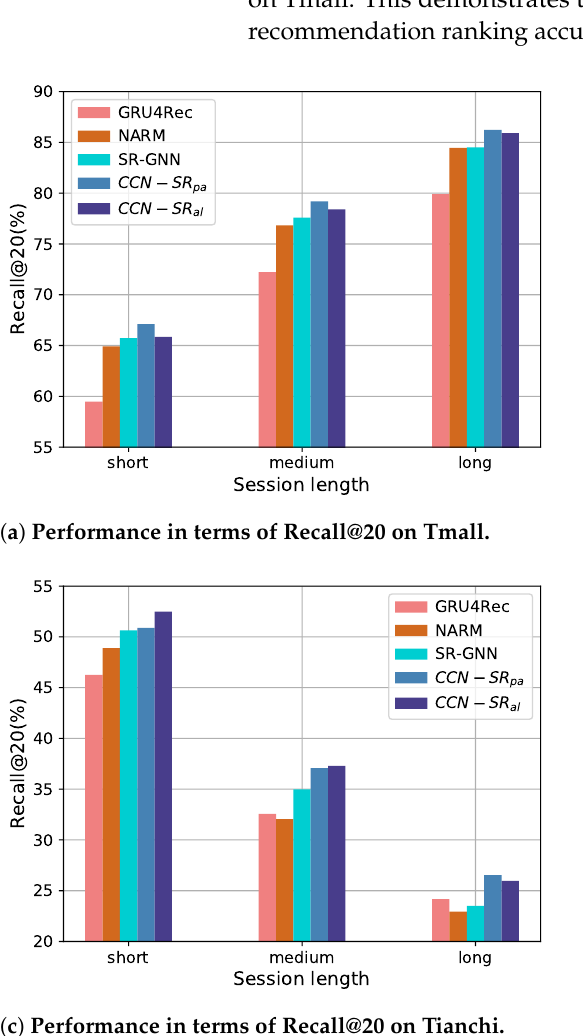
Figure 5. Effect on performance of five models in terms of Recall@20 and MRR@20 with different session lengths, tested on the Tmall and Tianchi